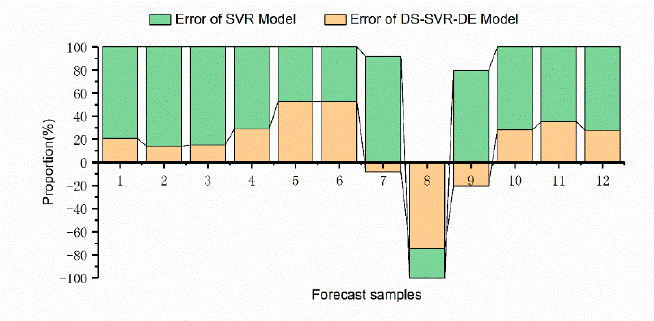
Figure 4. The long-term prediction performance of the proposed DS-SVR model and the SVR model (both adopt RFE algorithm for dimensionality reduction).